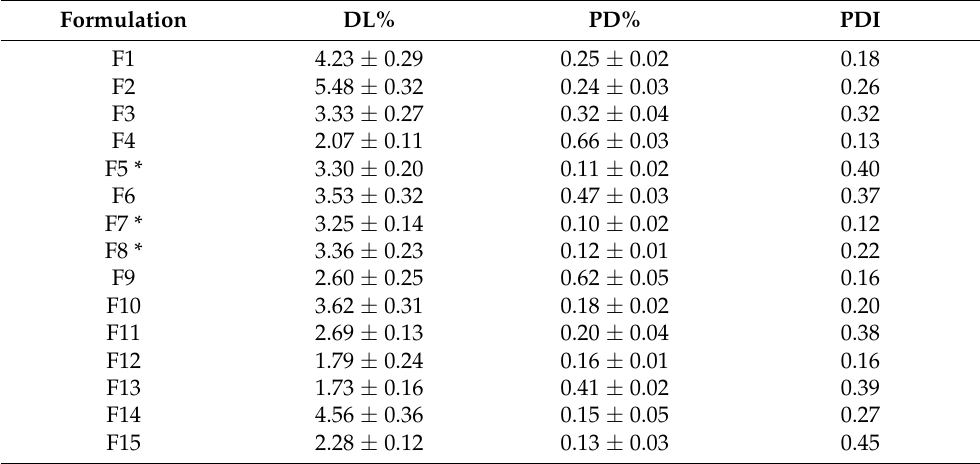
Table 4. The characteristic physicochemical properties of the investigated PRZ-PMMs formulations.